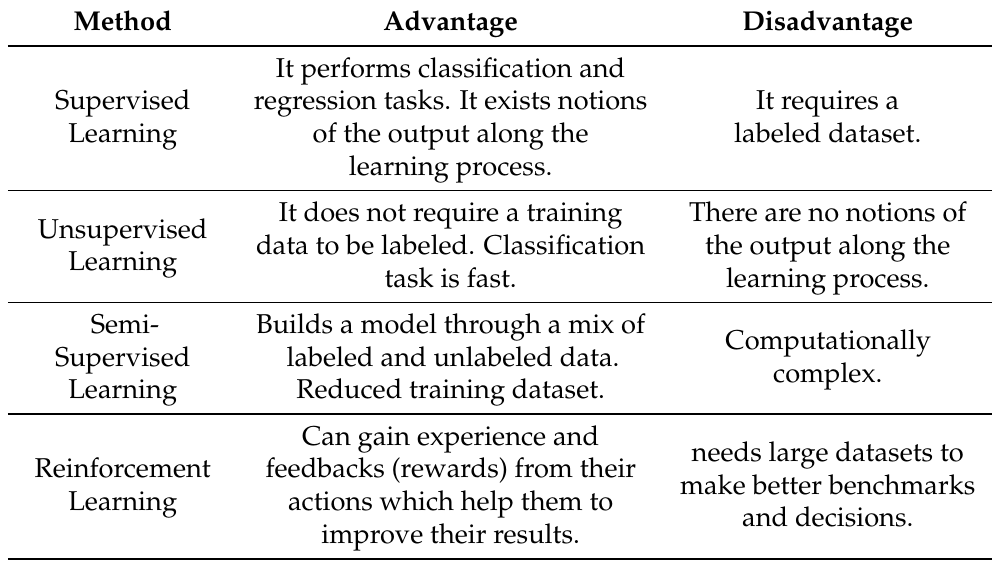
Table 1. ML approaches